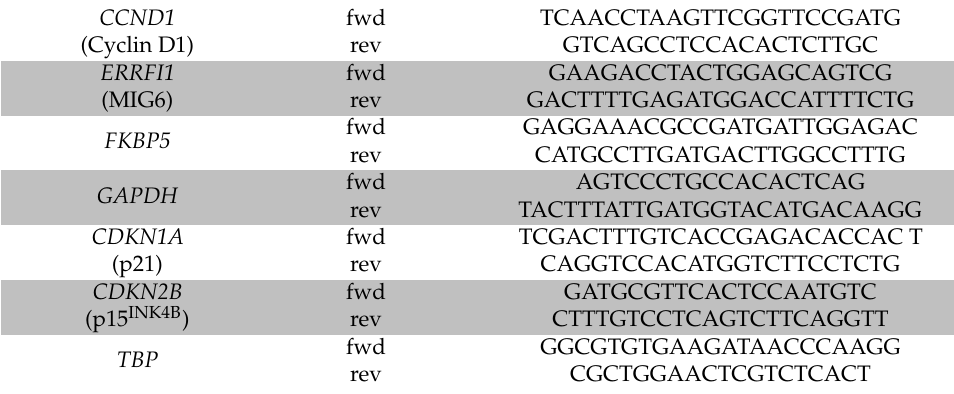
Table 1. Primers (5’ to 3’) used for